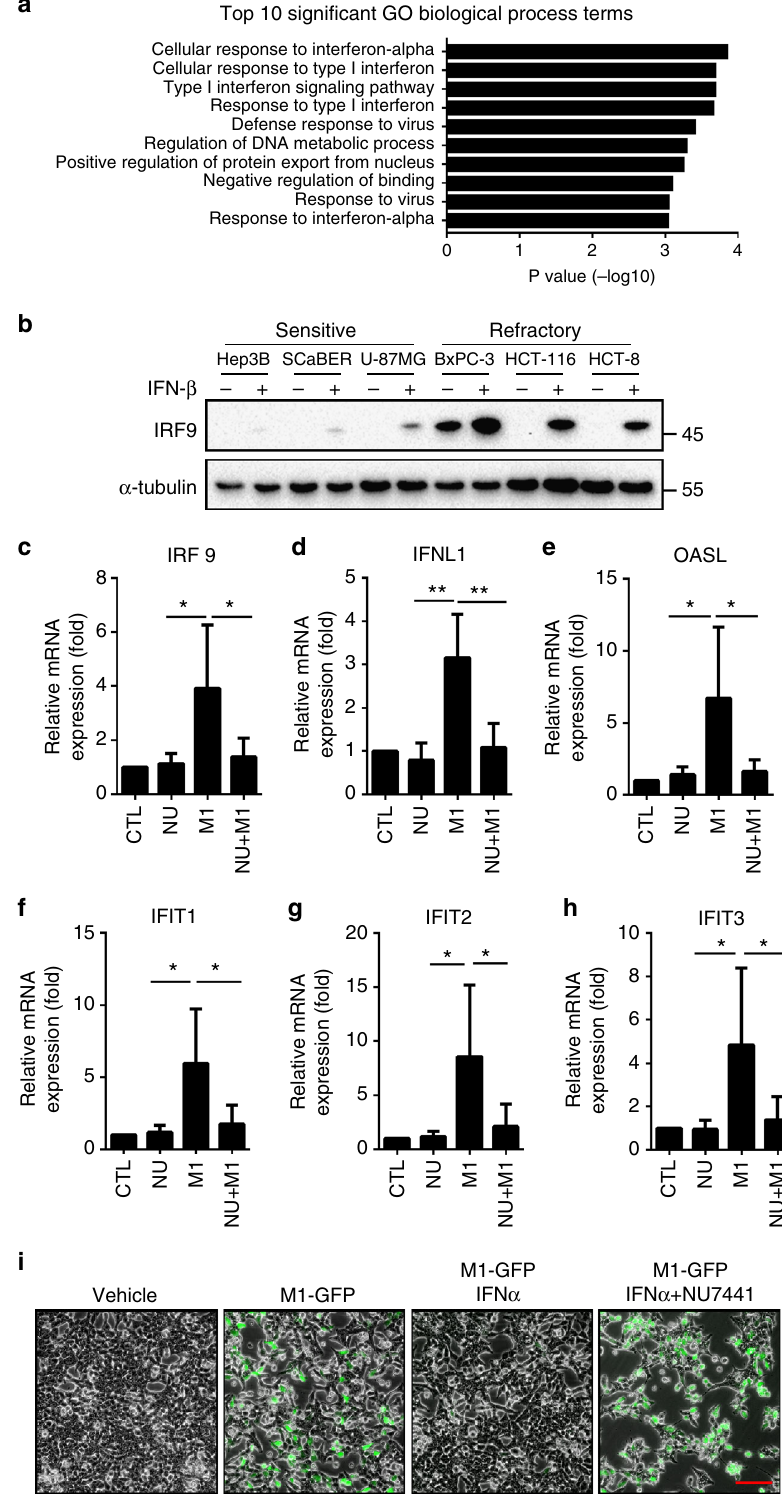
Fig. 4 DNA-PK inhibitors hinders M1 virus-induced IFN antiviral response. a Gene ontology analysis of the pathways that are overrepresented among the differentially expressed genes between the M1-treated or vehicle-treated HCT-116 cells. b Cells were treated with vehicle or IFN- β (10 ng/ μ l) for 16 h. Induction of IRF-9 was analysed by western blot. c – h HCT-116 cells were treated with vehicle or NU7441 (1 μ M, NU represent NU7441) and M1 virus (MOI = 1) for 24 h and then processed for the qRT-PCR to measure IFN-stimulated gene transcripts. n = 3. Data represent the mean ± SD. * P < 0.05; ** P < 0.01 by one-way ANOVA. i HCT-116 cells were pre-treated with NU7441 (1 μ M) for 1 h and then infected with M1-GFP at an MOI of 10 in the presence or absence of recombinant IFN α (1000 units/ml). GFP expression was monitored 48 h after M1 inoculation. Scale bar: 50 μ